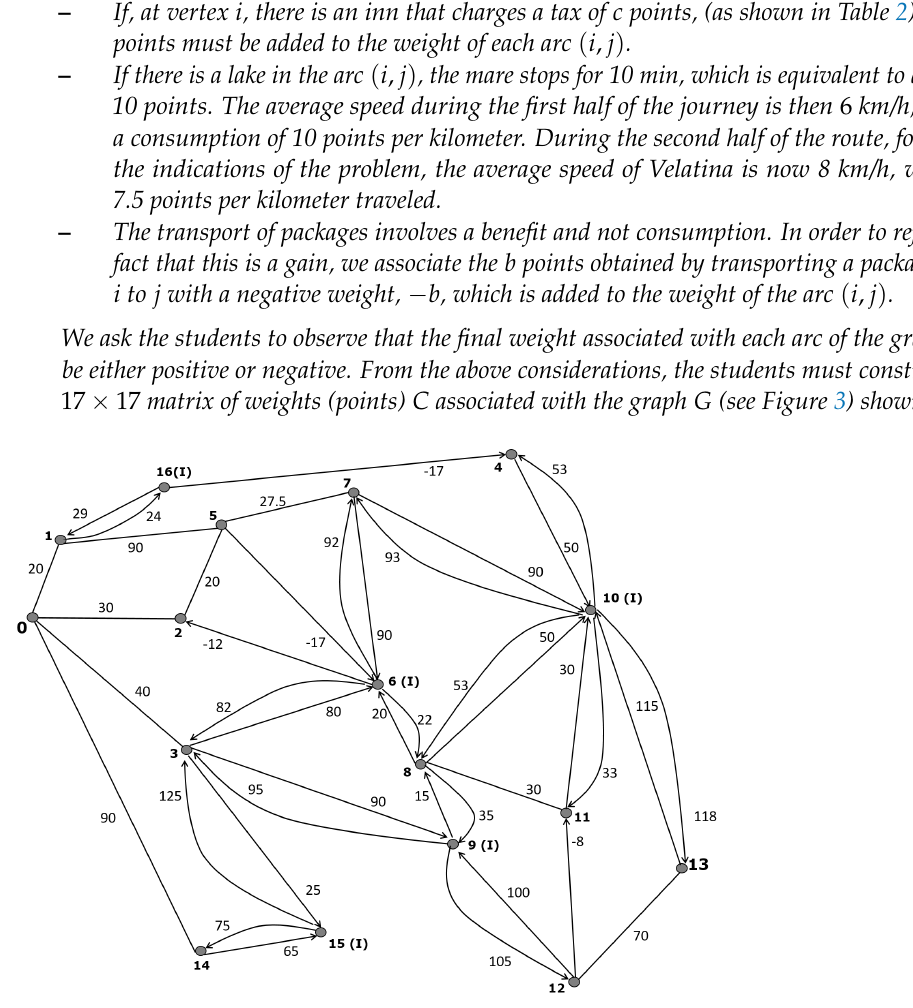
Figure 3. Graph associated with the map of Al-Bufera weighted with the costs obtained from the above